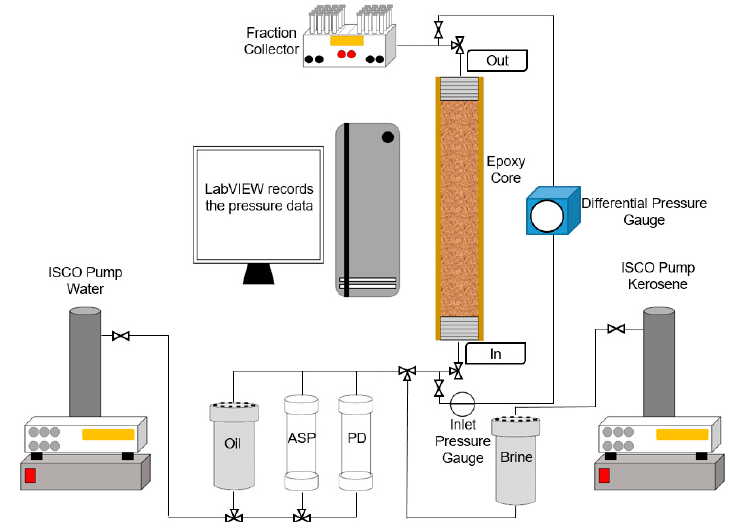
Figure 2. Schematic diagram of the experimental apparatus for the coreflooding test. ‘ASP’ stands for alkaline–surfactant–polymer and ‘PD’ represents the polymer drive.